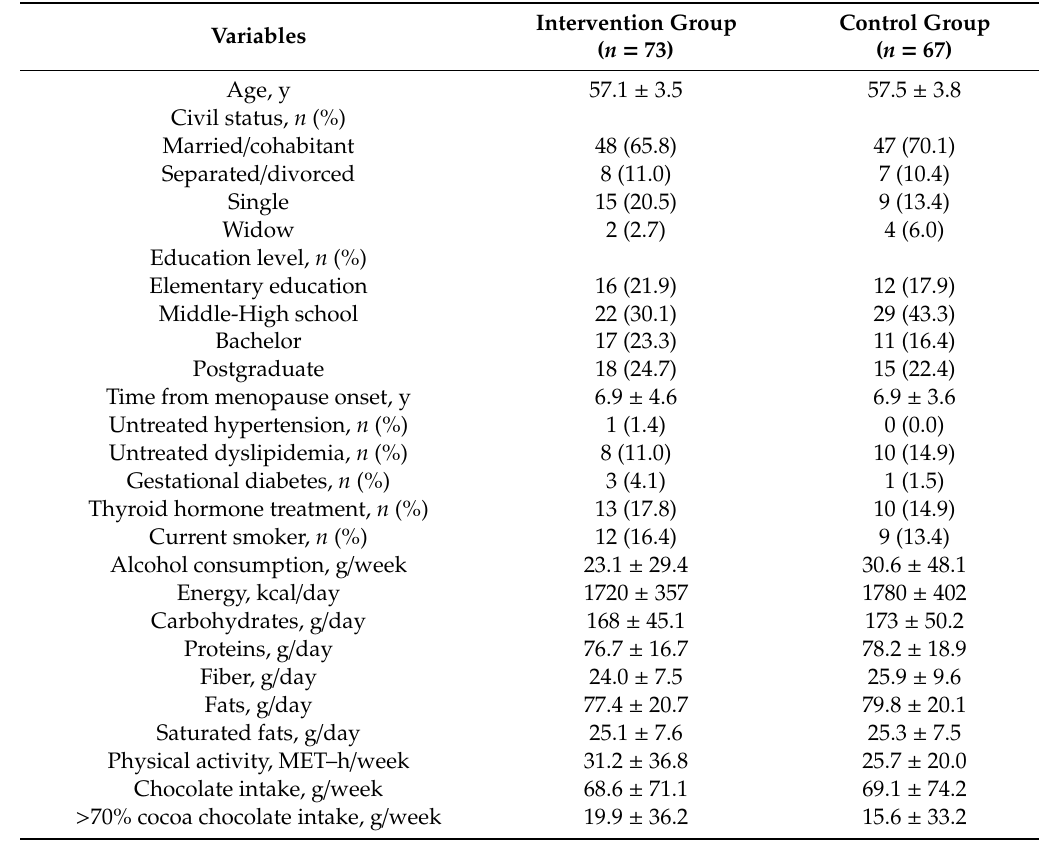
Table 2. Baseline characteristics of the postmenopausal women included in the study 1